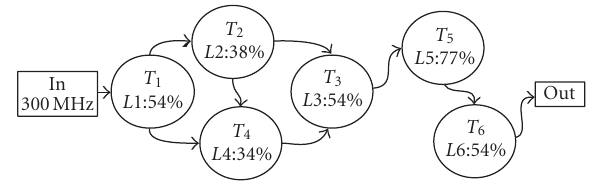
Figure 7: Application example composed of 6 tasks mapped on a 3 × 2-PE